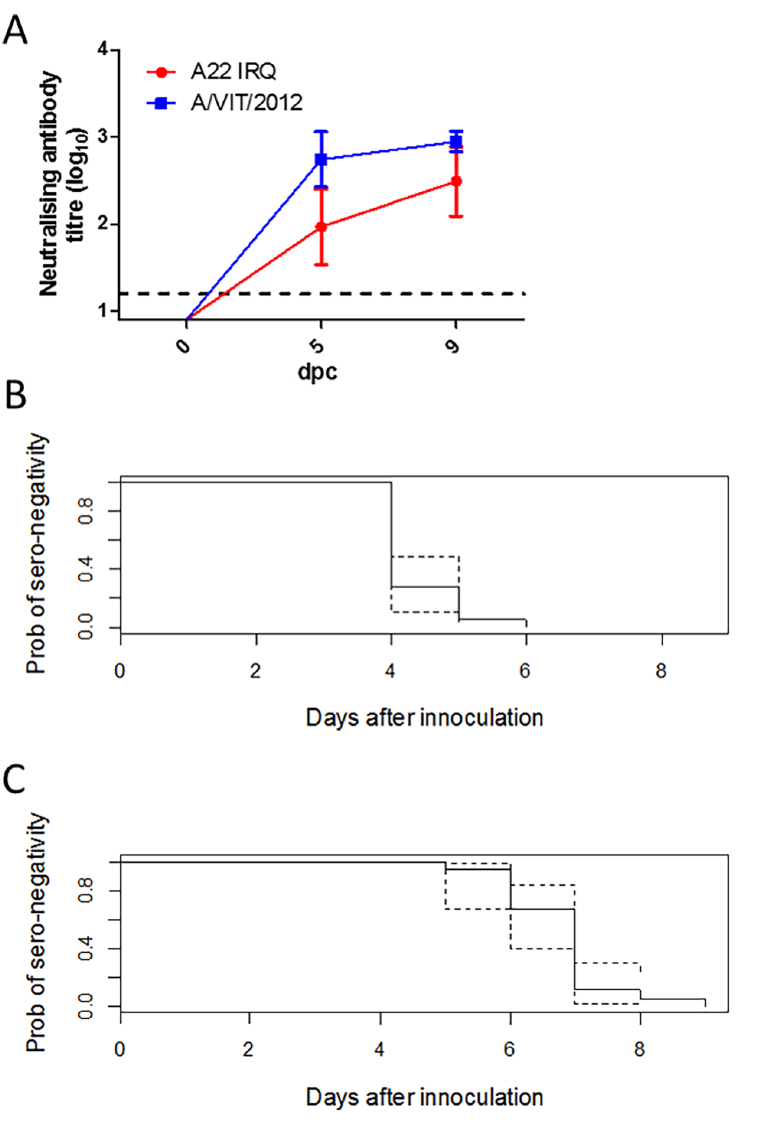
Fig 2. (A) Average neutralising antibody titres of the donor sheep sera to the vaccine virus (A22 IRQ) and the challenge virus (A/VIT/2012). Values represent Log 10 of the reciprocal of the highest dilution of serum that was able to neutralise either 100 TCID 50 of A22 IRQ or A/VIT/2012. The assay cut off was 0.9, titres (cid:21) 1.2 are considered positive. Time to seroconversion plots estimated by the Kaplan-Meier method for the donor sheep (B) for the structural protein ELISA; and (C) for the non-structural protein ELISA. The dotted lines are the estimated 95% confidence limits.